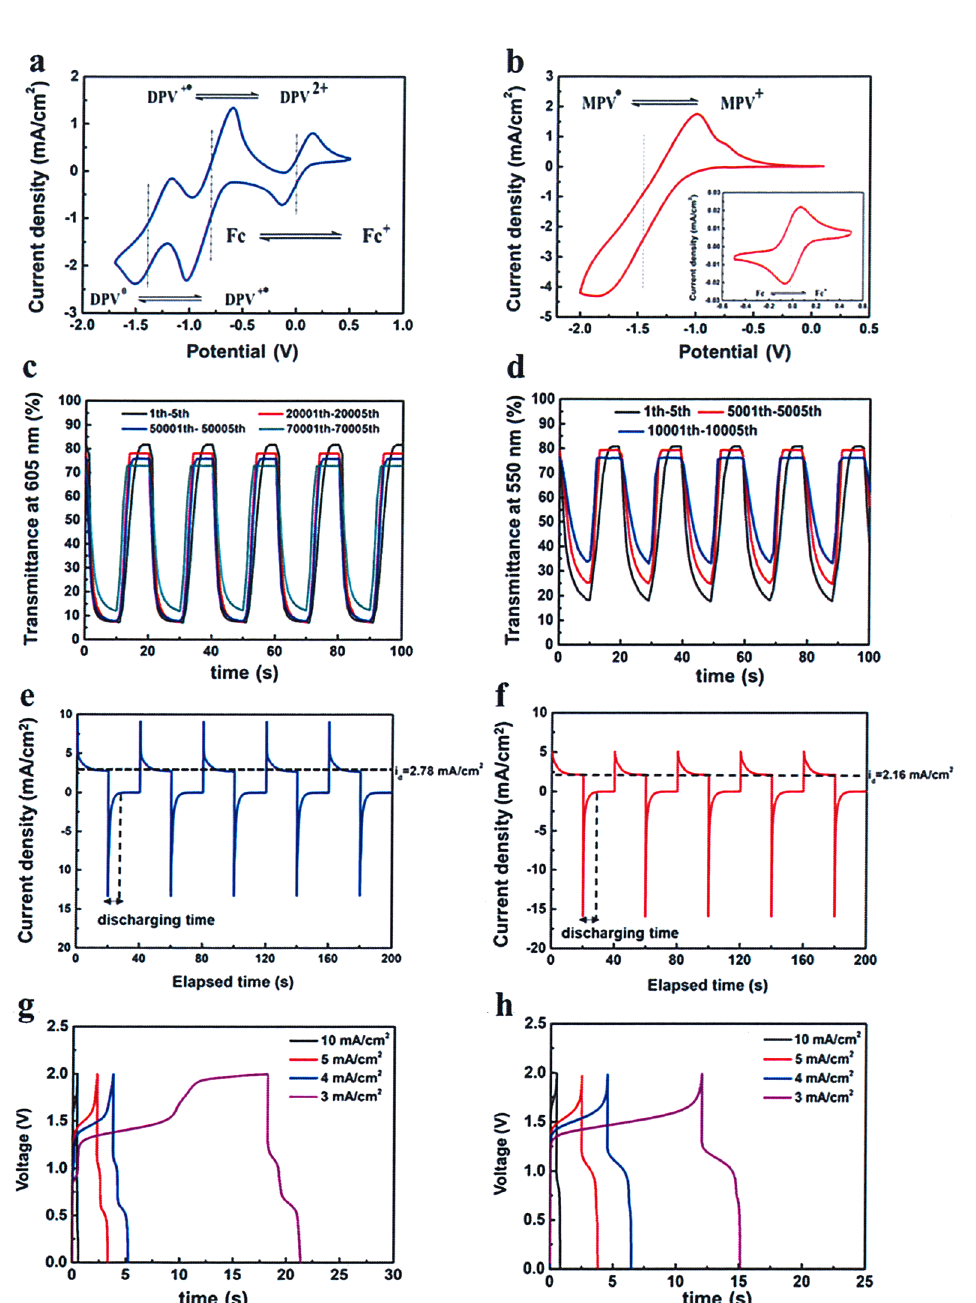
Fig. 3 Performances of gel ECDs based on DPV and MPV. (DPV: a , MPV: b ) Cyclic voltammograms at a scan rate of 100 mV/s; (DPV: c , MPV: d ) chronoabsorptometry at different switching cycles between colored state (1.6 V for 10 s) and bleached state ( − 0.3 V for 10 s); (DPV: e , MPV: f ) current densities versus elapsed time switching between 1.6 V (colored state, 20 s) and 0 V (bleached state, 20 s); (DPV: g , MPV: h ) galvanostatic charge – discharge (GCD) curves of ECSs under increasing current densities from 3 to 10 mA/cm 2 . NATURE COMMUNICATIONS| (2021) 12:1010